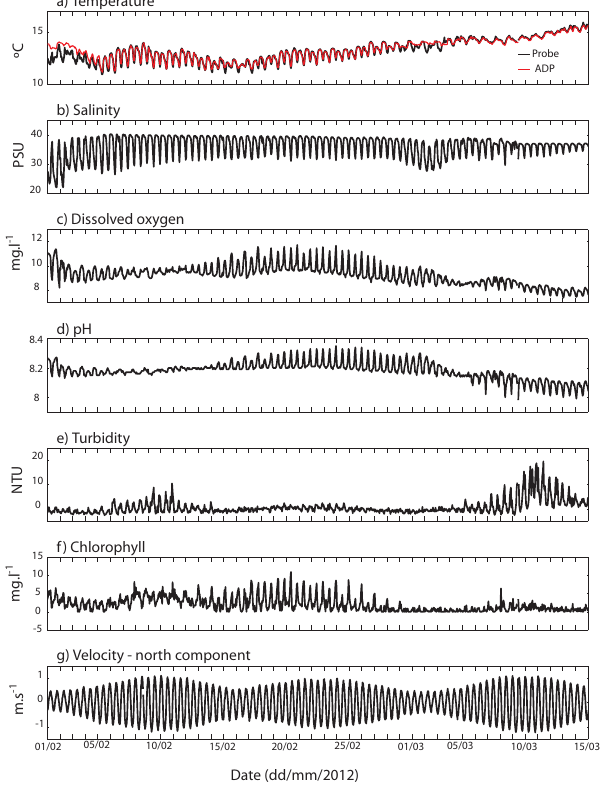
Figure 5. Subset of the probe and ADP time series in February– March 2012. For explanation, see